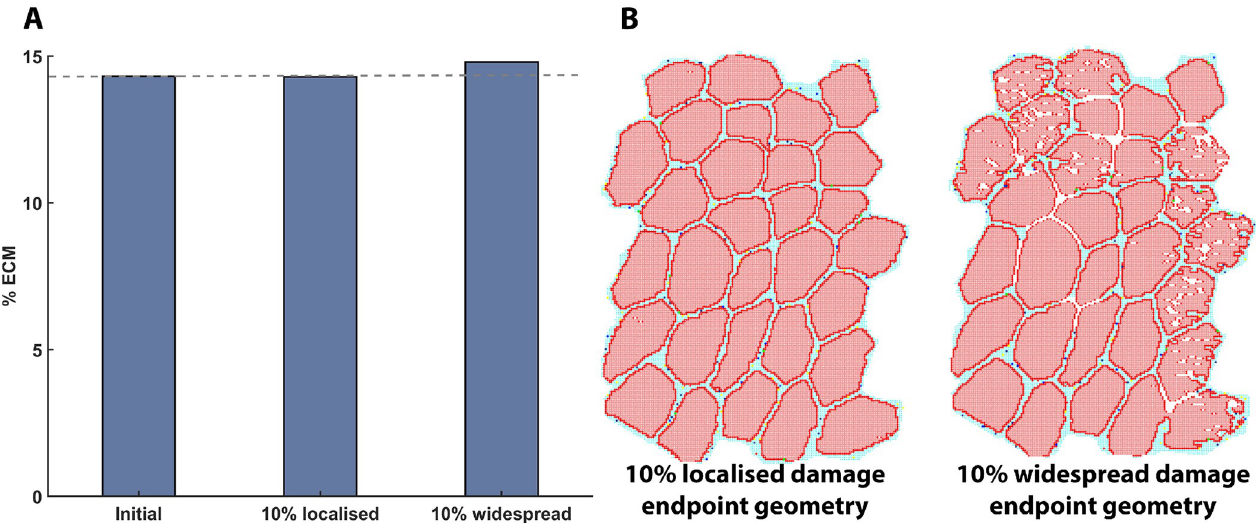
Fig 5. ECM changes during regeneration simulations. (A) Change in percentage ECM at endpoint from initial, for 10% localised and 10% widespread damage, and (B) change in endpoint ABM geometry from starting geometry for 10% localised and 10% widespread damage. Widespread damage leads to gaps in muscle fibres and changes in fibre